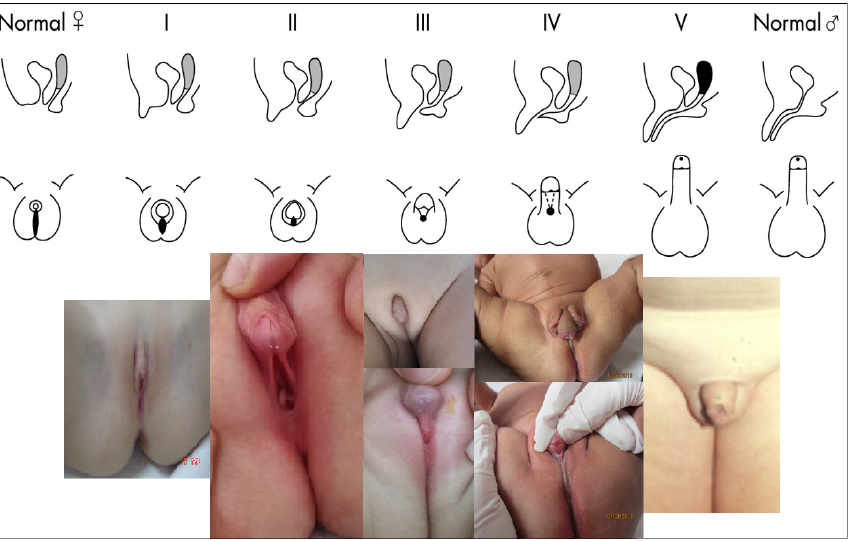
Figure 7. Prader stages with clinical examples for each stage [45]. Written informed consent was obtained from the parents for publication of this photos.